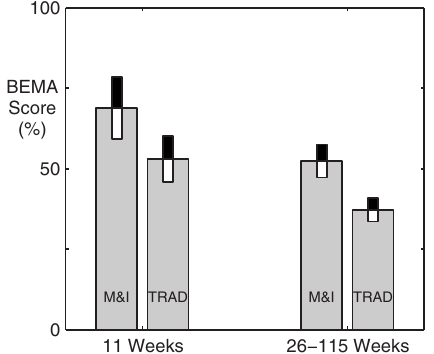
FIG. 9. Retention of E&M knowledge—average scores on the BEMA vs time since completion of a course in introductory E&M are shown for students at CMU from either a traditional curriculum (cid:1) TRAD (cid:2) or the M&I curriculum. The error bounds indicate 95% confidence intervals on the estimates of the average for each sec- tion. The numbers of students tested were 116 for traditional and 73 for M&I.